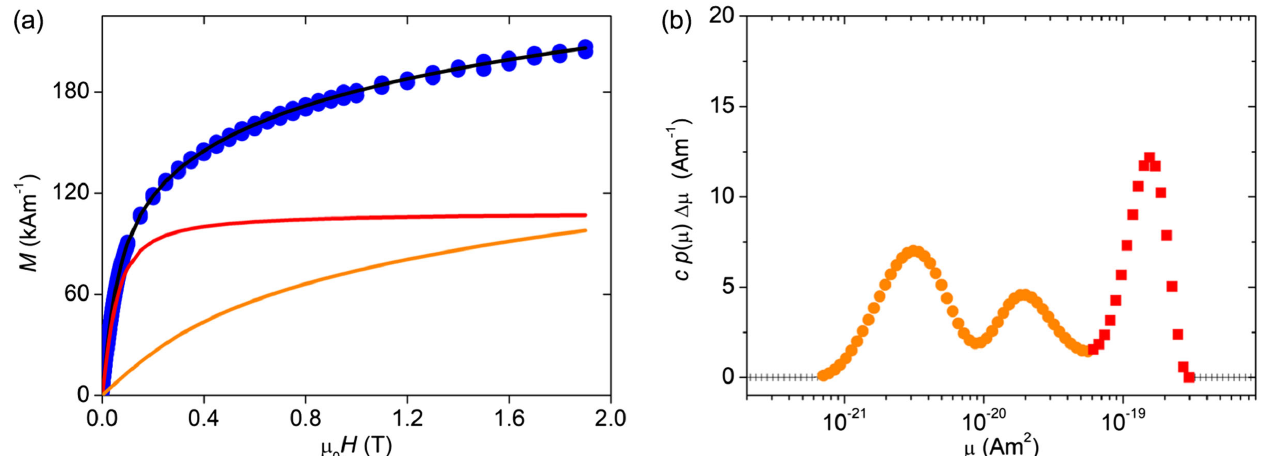
FIG. 9. Macroscopic magnetization measurement analyzed by numerical inversion. (a) VSM data (blue data) and reconstructed data by numerical inversion (black line). The red and orange contributions arise from the extracted large and small magnetic moment distributions, respectively, indicated in (b). c denotes a scaling factor and Δ μ the binning width.